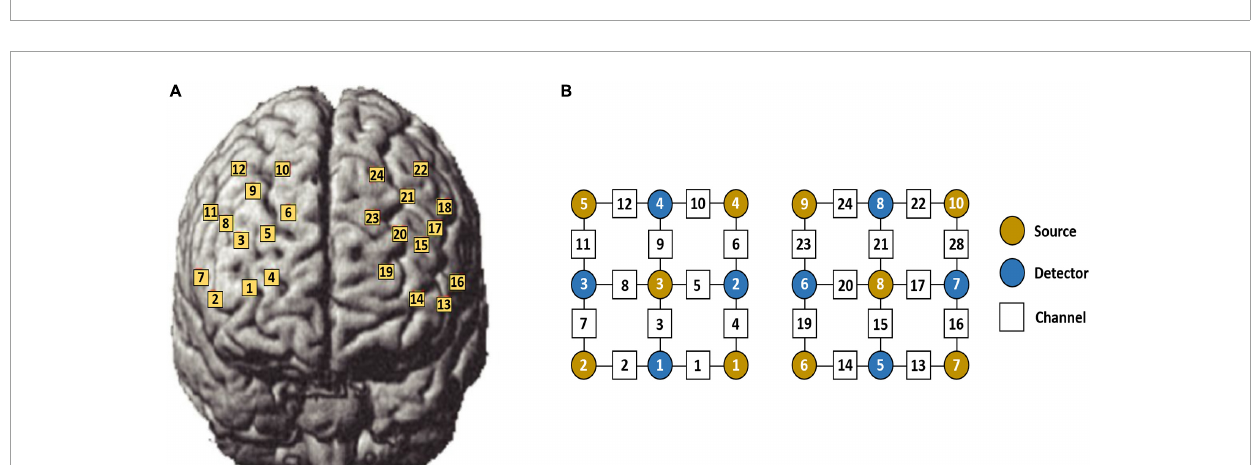
FIGURE2 Experimental procedures.